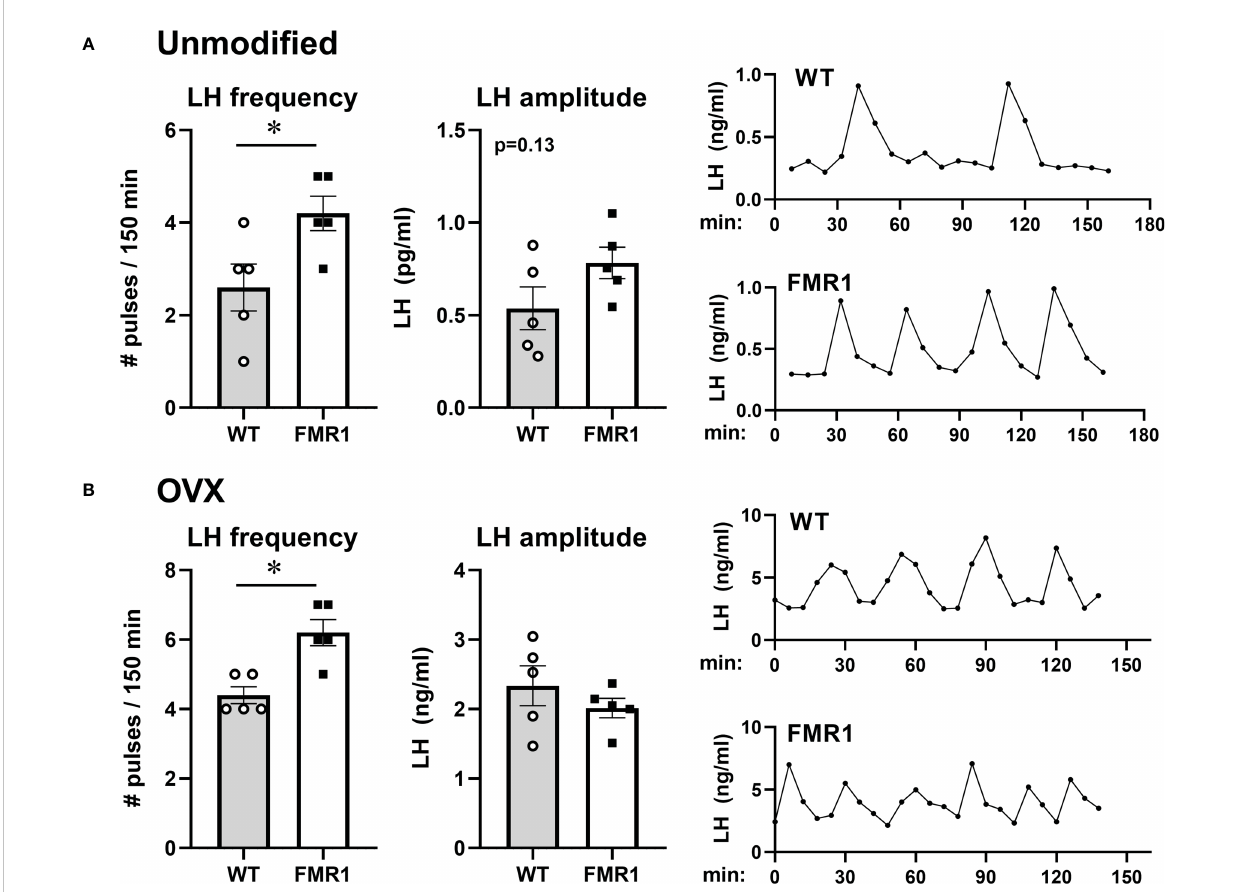
FIGURE 11 Higher LH/GnRH pulse frequency in Fmr1 KO females before and after ovariectomy. LH pulse frequency re fl ects GnRH neuron activity. (A) Frequent tail-tip whole blood sampling over 3 hours demonstrate higher pulse frequency of LH in Fmr1 KO female mice in diestrus. Representative pro fi les from WT control in the top and Fmr1 KO at the bottom (right side), pulse frequency calculated from pulse pro fi les using DynPeak (left); amplitude was determined by subtracting the LH value at the peak from the basal value prior to the onset of the pulse and averaged for each mouse (middle). (B) LH pulse in ovariectomized (OVX) animals. Statistical signi fi cance (p < 0.05), determined with t-test followed by Tukey ’ s post hoc test, is indicated with a